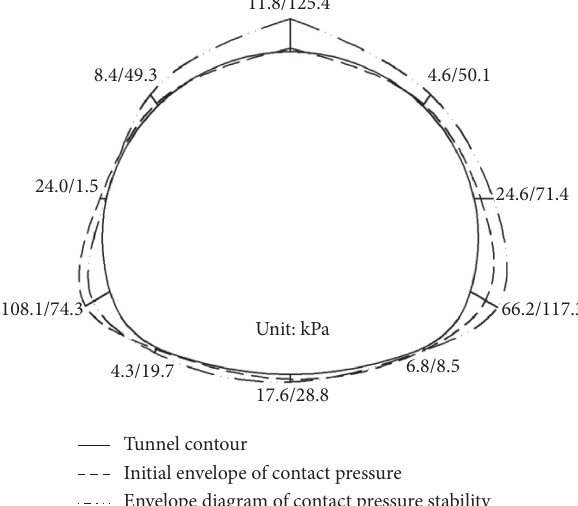
Figure 13: Envelope diagram of early third tunnel DK-190+617 mileage contact pressure.